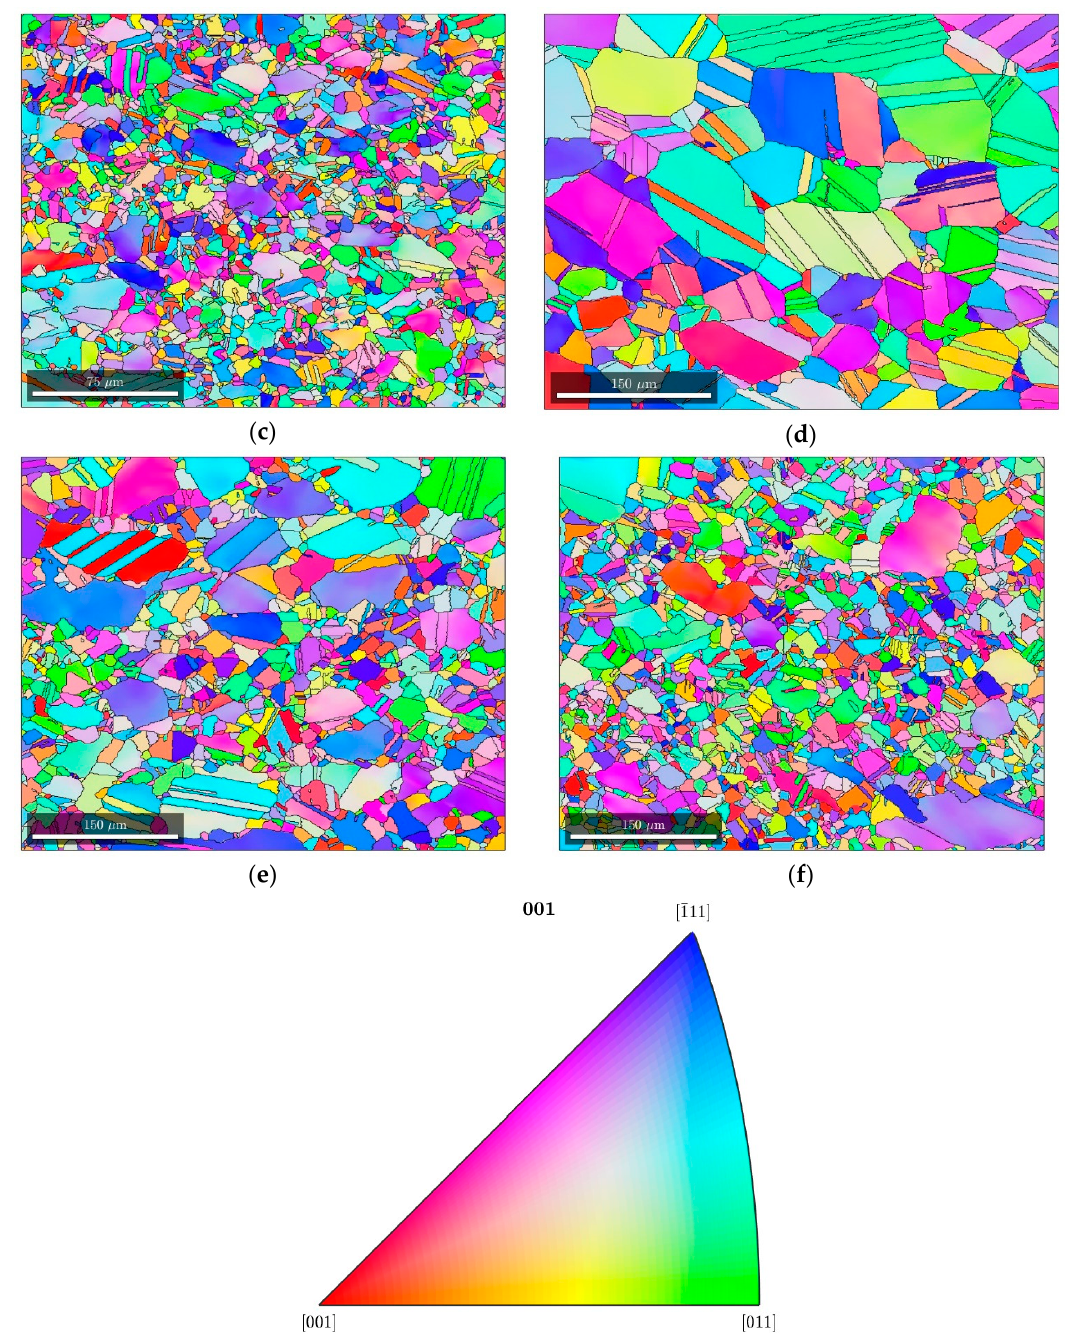
Figure 1. OIM maps with IPF-Z coloring of plates hot rolled at 1050 °C and with a deformation levels of 4.6 ( a ), 12.7 ( b ) and 23.5% ( c ) and hot rolled at 1150 °C with a deformation levels of 5.7 ( d ), 14.4 ( e ) and 25.2% ( f ) and IPF-Z color triangle ( h ).